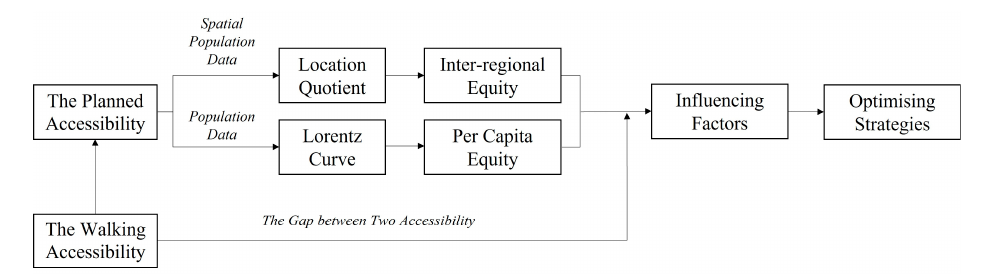
Figure 3. Methods workflow.